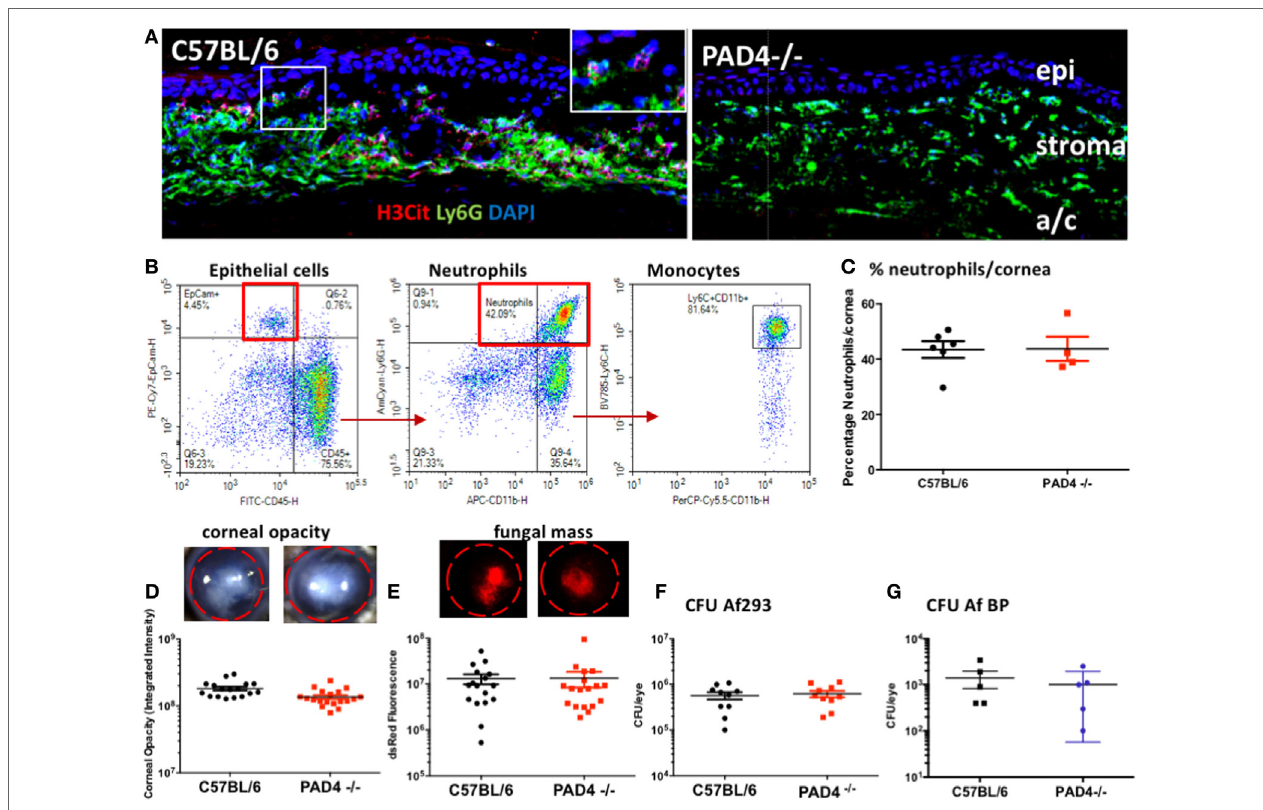
FigUre 8 | Aspergillus fumigatus corneal infection in PAD4 − / − mice. Corneas of C57BL/6 and PAD4 − / − mice were infected with dsRed expressing A. fumigatus. (a) Corneal sections immunostained with antibodies to Ly6G and citrullinated histone 3 (H3Cit) and counterstained with DAPI nuclear stain. Epi, stroma = corneal epithelium and corneal stroma. Highlighted area shows H3Cit staining in neutrophils. Original magnification is 400 × . (B) Representative flow cytometry scatter plots showing total cells from infected C57BL/6 corneas that include CD45 − epithelial cells, CD45 + Ly6G + neutrophils, and Ly6C high monocytes. (c) Percent neutrophils in infected corneas from C57BL/6 and PAD4 − / − mice [percent Ly6G + neutrophils in infected corneas (representative scatter plots from C57BL/6 and PAD4 − / − mice are shown in Figure S2 in Supplementary Material)]. (D,e) Representative corneas showing opacification and RFP expressing A. fumigatus hyphae. (F,g) Quantification of corneal opacity, dsRed as a measure of fungal mass, and CFU. Each data point represents an individual cornea. p > 0.05 using Student’s t -test analyses for panels (c–g) , indicating that there are no statistically significant differences between C57BL/6 and PAD4 − / − mice for any of these parameters. These data are representative of five repeat